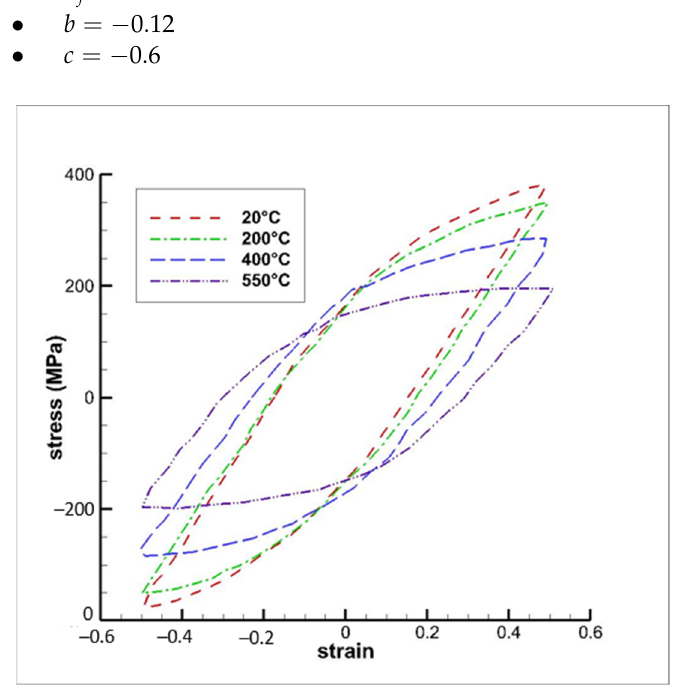
Figure 3. Precipitation-hardened CuCrZr-Saturated loops at different temperatures [14].